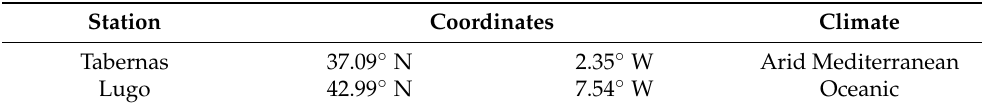
Table 1. Measurement